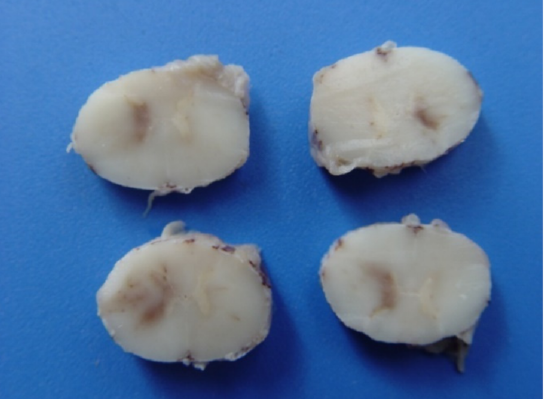
Figure 3. Hemorrhagic focuses in the gray and white matter of the spinal cord of an animal positive to equine herpesvirus myeloencephalopathy submitted to necropsy.